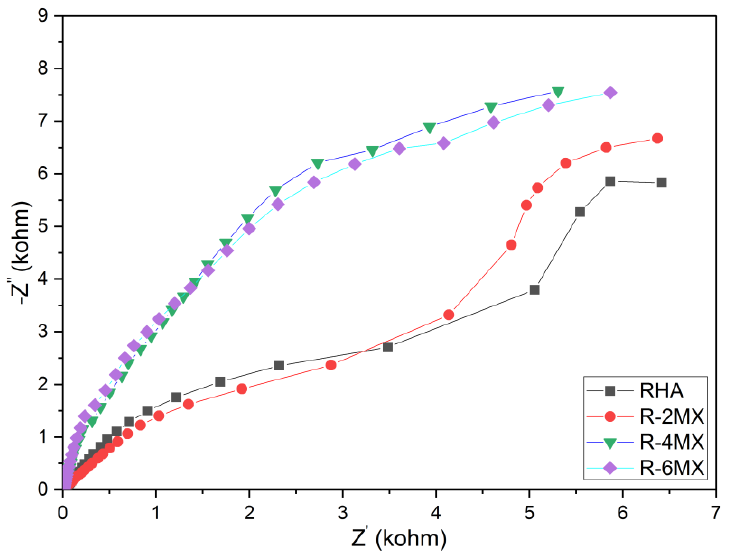
Figure 8. Nyquist plot of plain RHA and different compositions of R-MX.